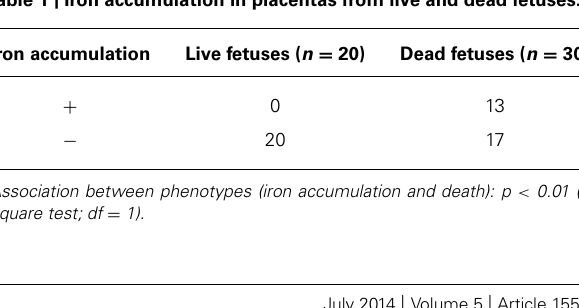
FIGURE 2 | Trophoblast response to IE binding. (A) Cytoadhesion of IE to trophoblast (TB) via VAR2CSA-CSA interaction leads to chemokine production by these activated cells (B) and recruitment of inflammatory